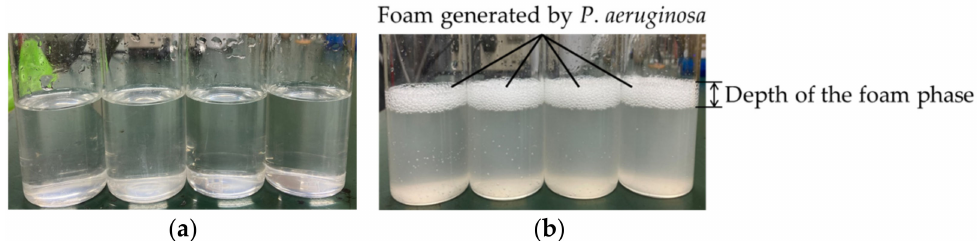
Figure 1. Foam generation by P. aeruginosa : ( a ) the original culture medium; ( b ) the foam generated by P. aeruginosa and the depth of the foam